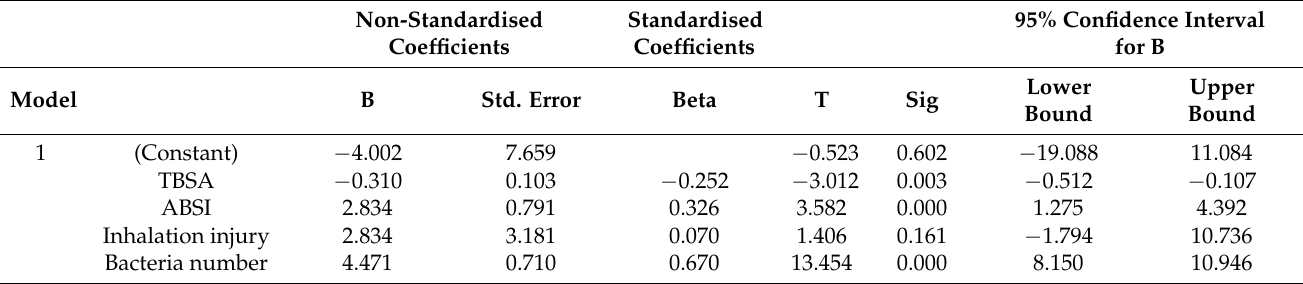
Table A3. Coefficients (a).